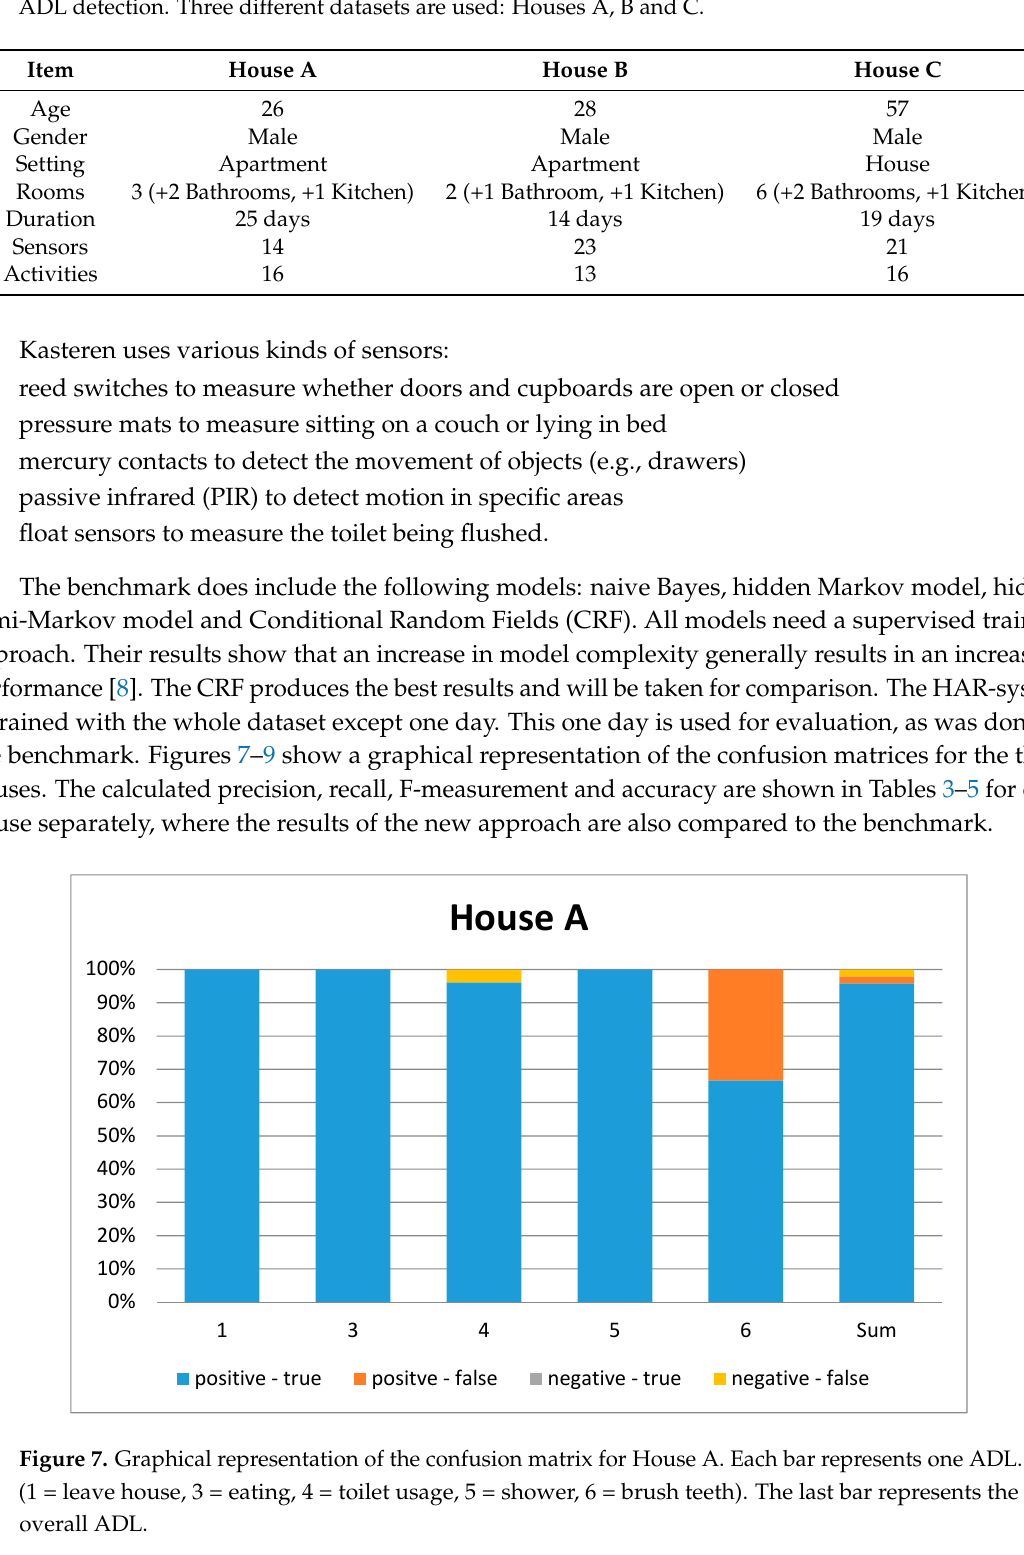
Table 2. Characteristics of the publicly available dataset that was used to evaluate the new approach of ADL detection. Three different datasets are used: Houses A, B and C.